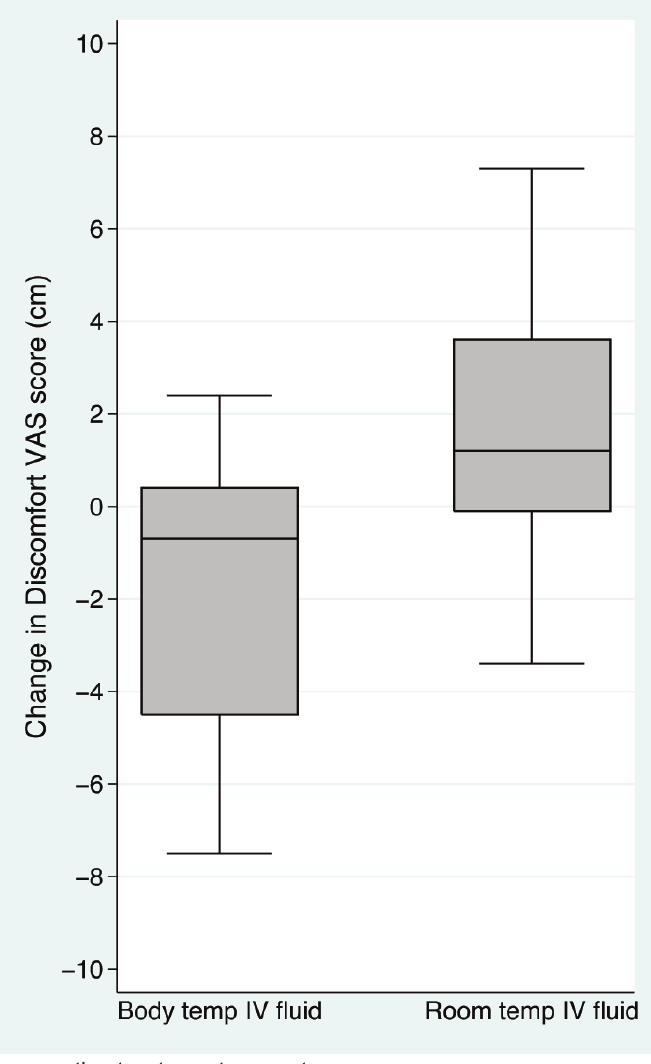
Figure 2 . Box plot of the change in Discomfort Visual Analogue Scale (VAS) score associated with body temperature (ΔVAS ) body and room temperature (ΔVAS ) intravenous (IV) fluid treatment. room A negative change in Discomfort VAS score indicated the subject reported less discomfort after the IV fluid treatment than before the treatment. Within each box plot, the center line represents the median, the box contains the interquartile range, and whiskers represent the minimum and maximum